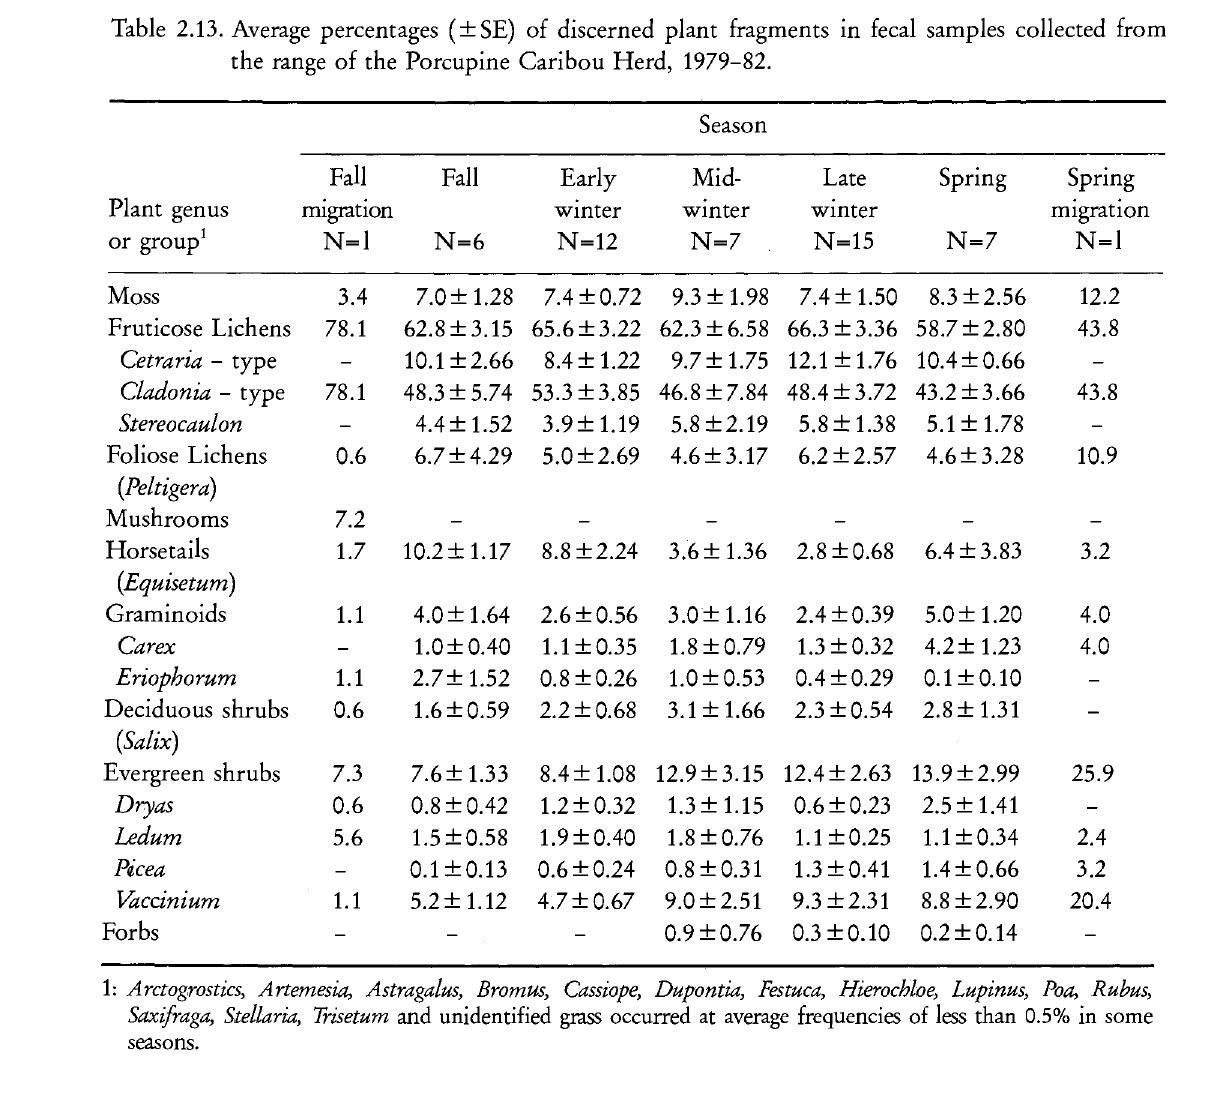
Table 2.13. Average percentages (±SE) of discerned plant fragments in fecal samples collected from the range of the Porcupine Caribou Herd, 1979-82.